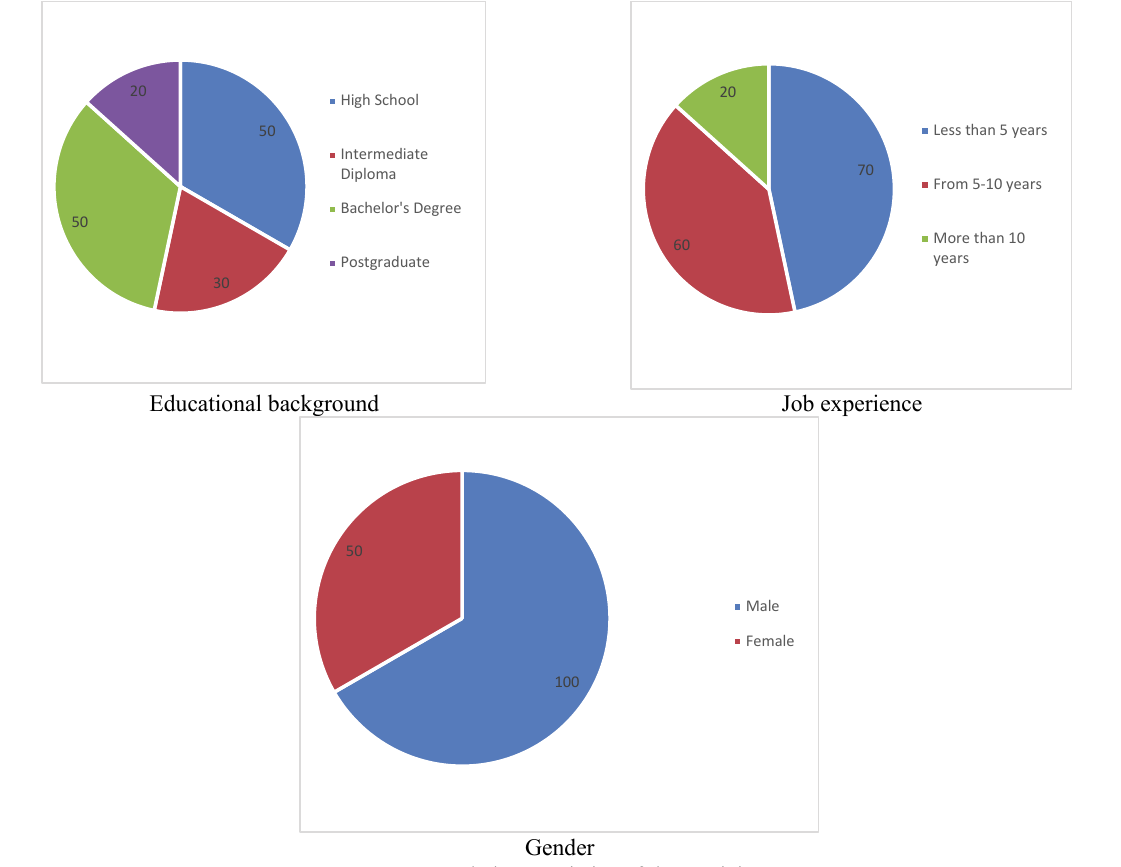
Fig. 1. Personal characteristics of the